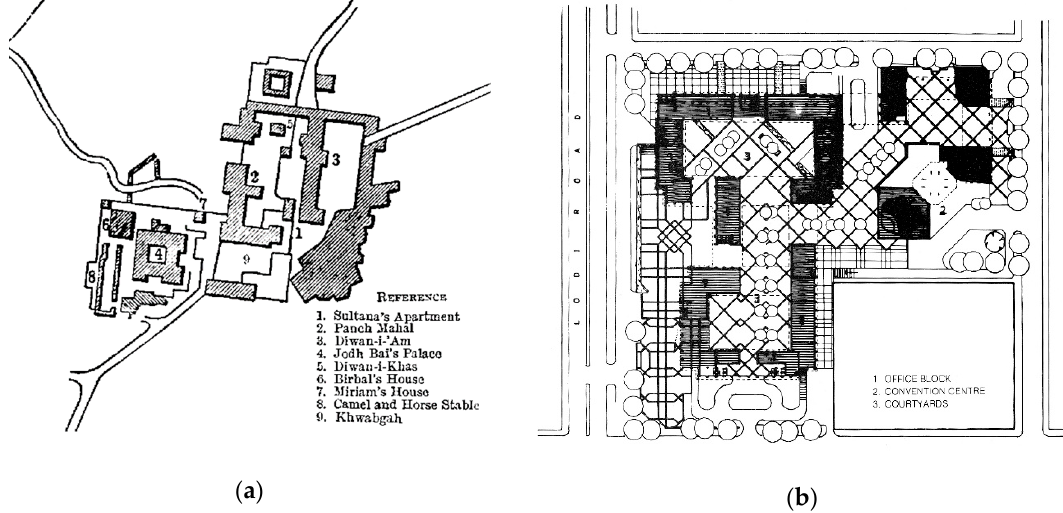
Figure 15. Interlinked shaded courtyards in the site plans of: ( a ) Fatehpur Sikri Palace [30] and ( b ) India Habitat Centre [31].